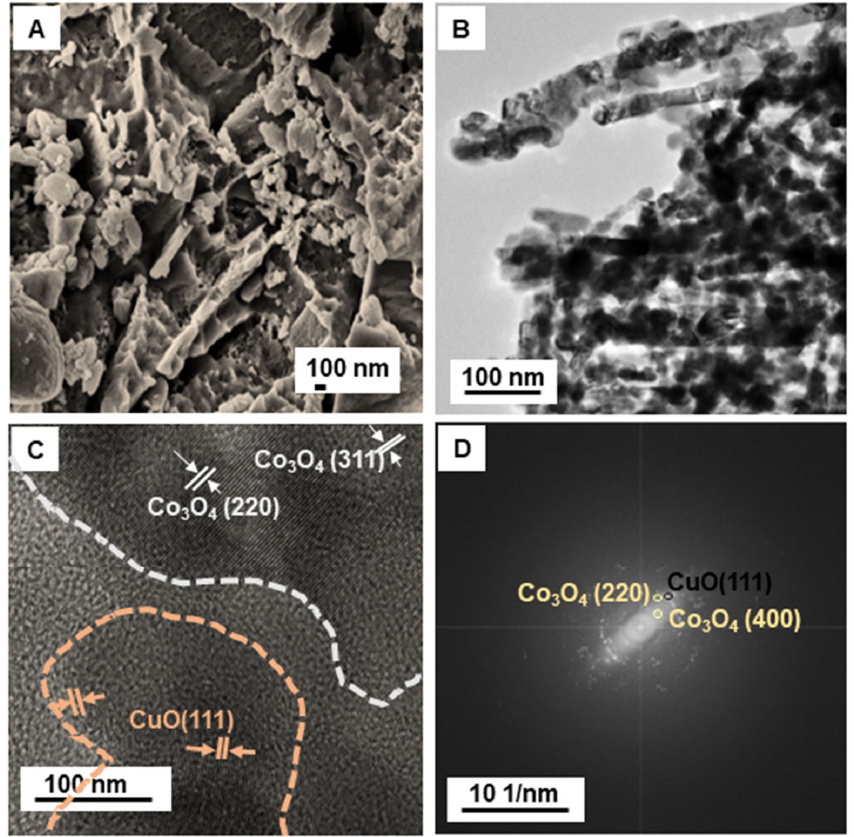
Figure 2. ( A ) SEM, ( B ) TEM, ( C ) HRTEM, and ( D ) FFT images of CCuU.